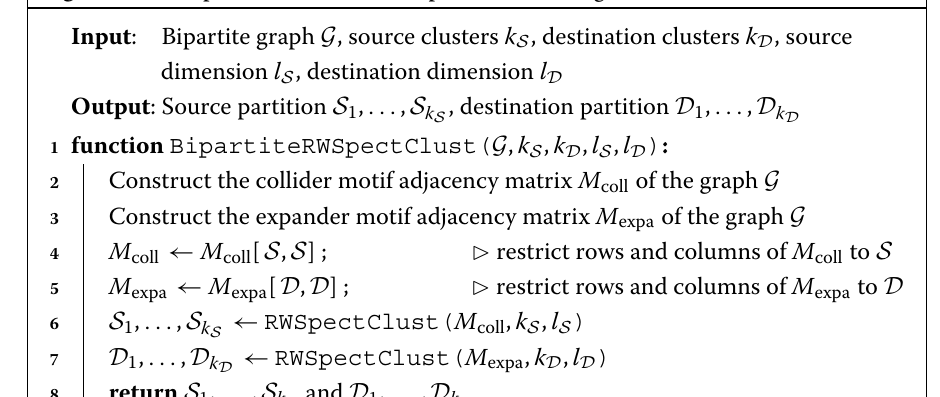
Algorithm 3: Bipartite random-walk spectral